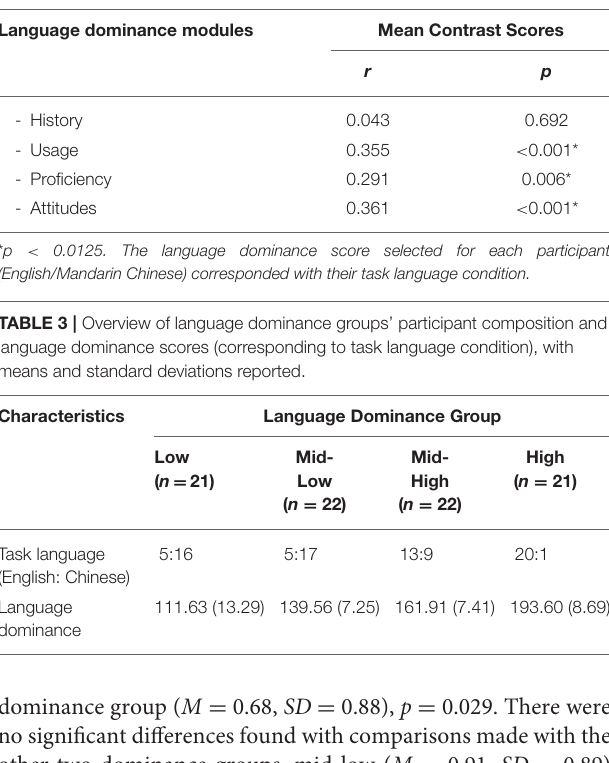
TABLE 2 | Pearson’s correlation coefficients between mean scenario contrast scores and language dominance module scores across of participants ( N = 86).